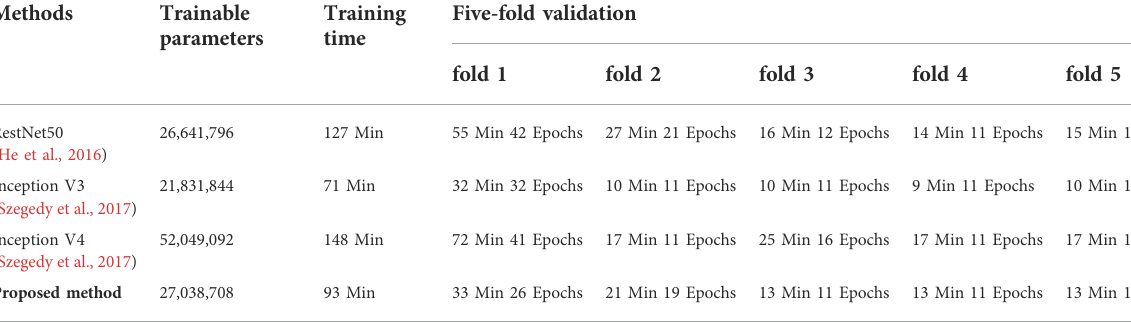
TABLE 6 Comparison of the computational cost of the proposed 3D method VS . reference models.